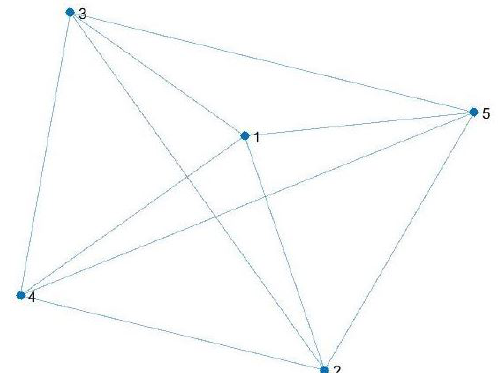
Figure 2. The graph G ( δ ) with δ = 0.5. Vertex number refers to the associated